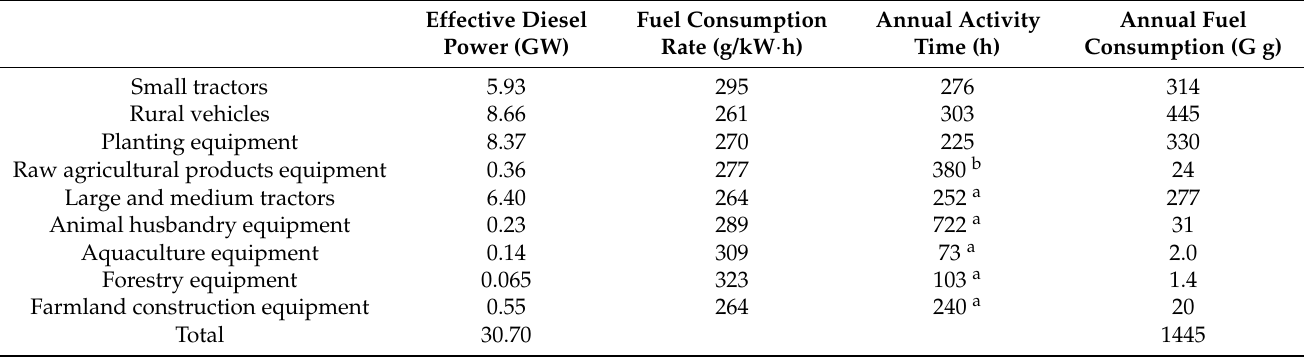
Table 4. Total fuel consumption of diesel AM in Anhui in